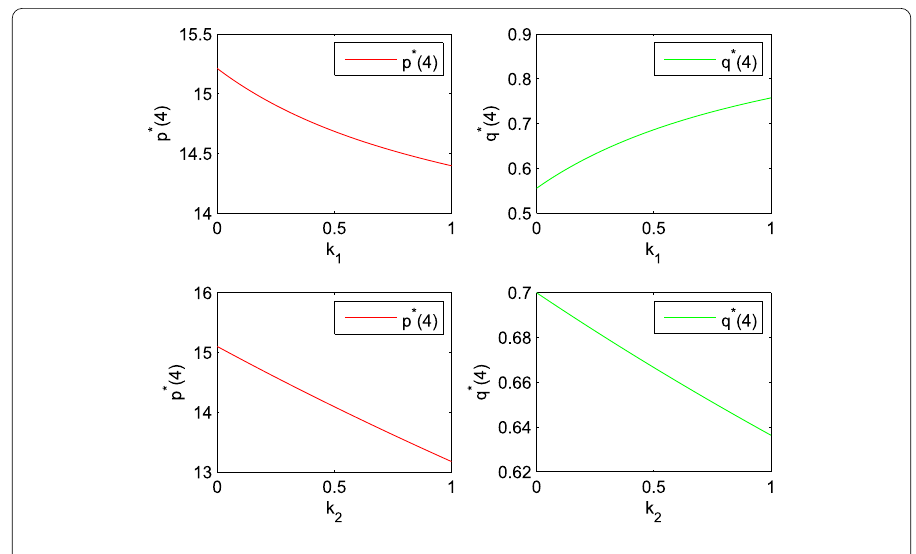
Figure 10 Effects of the sensitivity coefficients on p ∗ (4) and q ∗